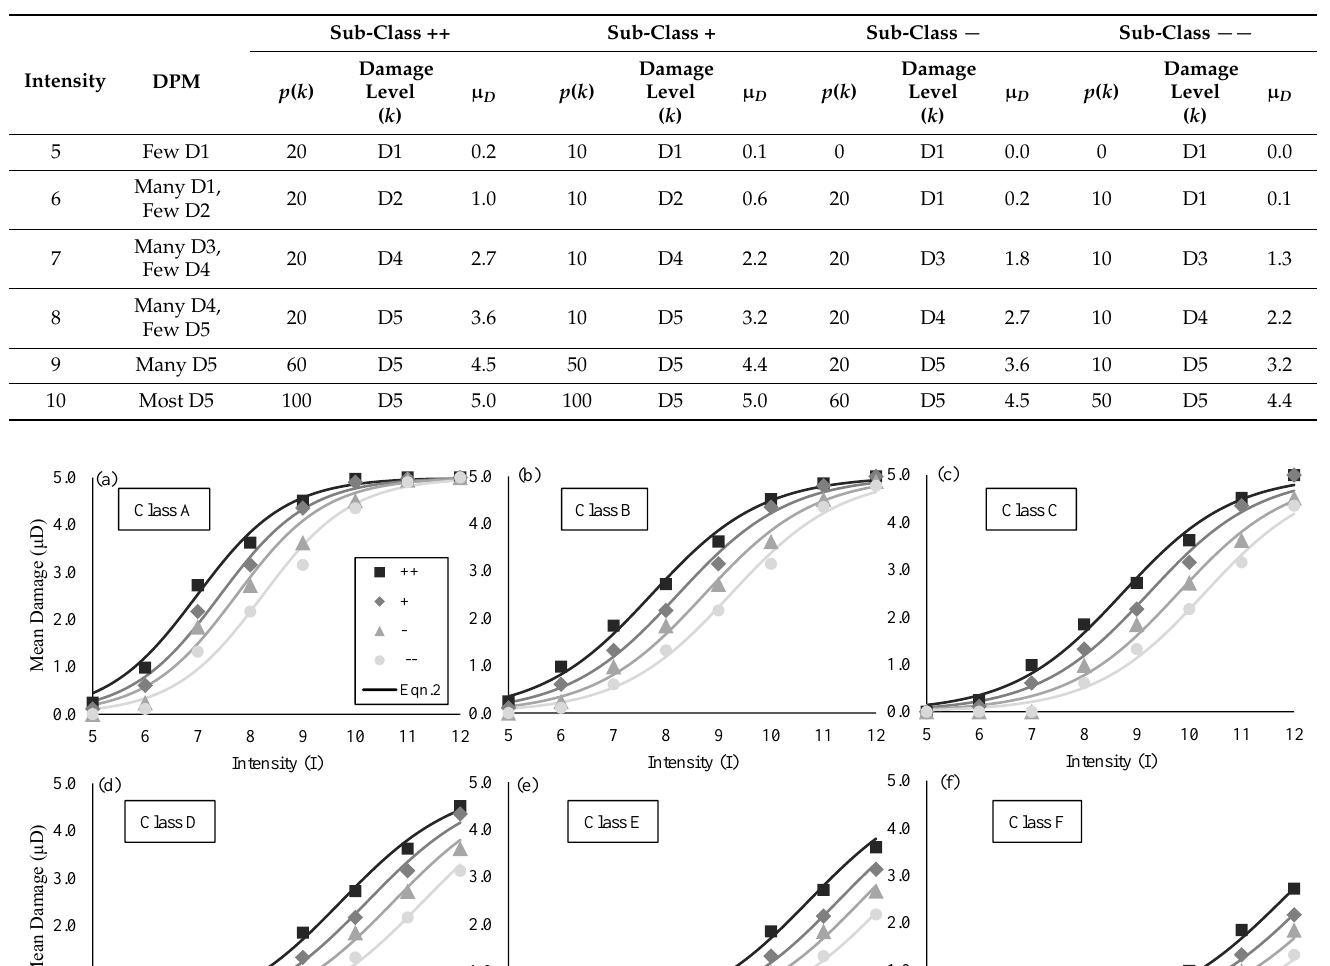
Table 4. Mapped probability of damage ( p ) for the vulnerability class A.